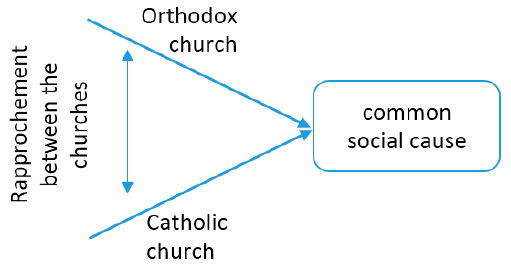
Figure 1. Rapprochement between the churches in the public square.